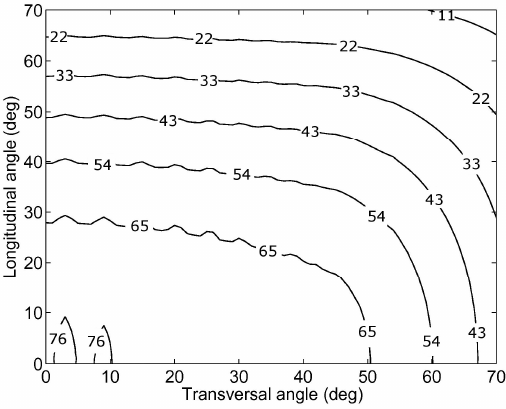
Figure 4. Optical efficiency of the heliostat solar field.